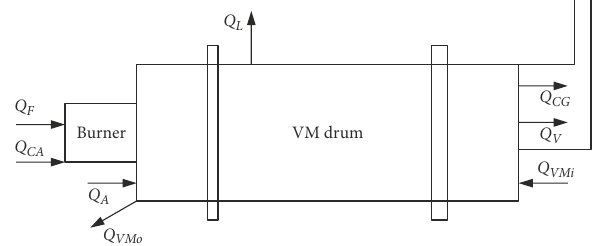
Figure 2. Heat balance model in the virgin mineral material counter flow drum